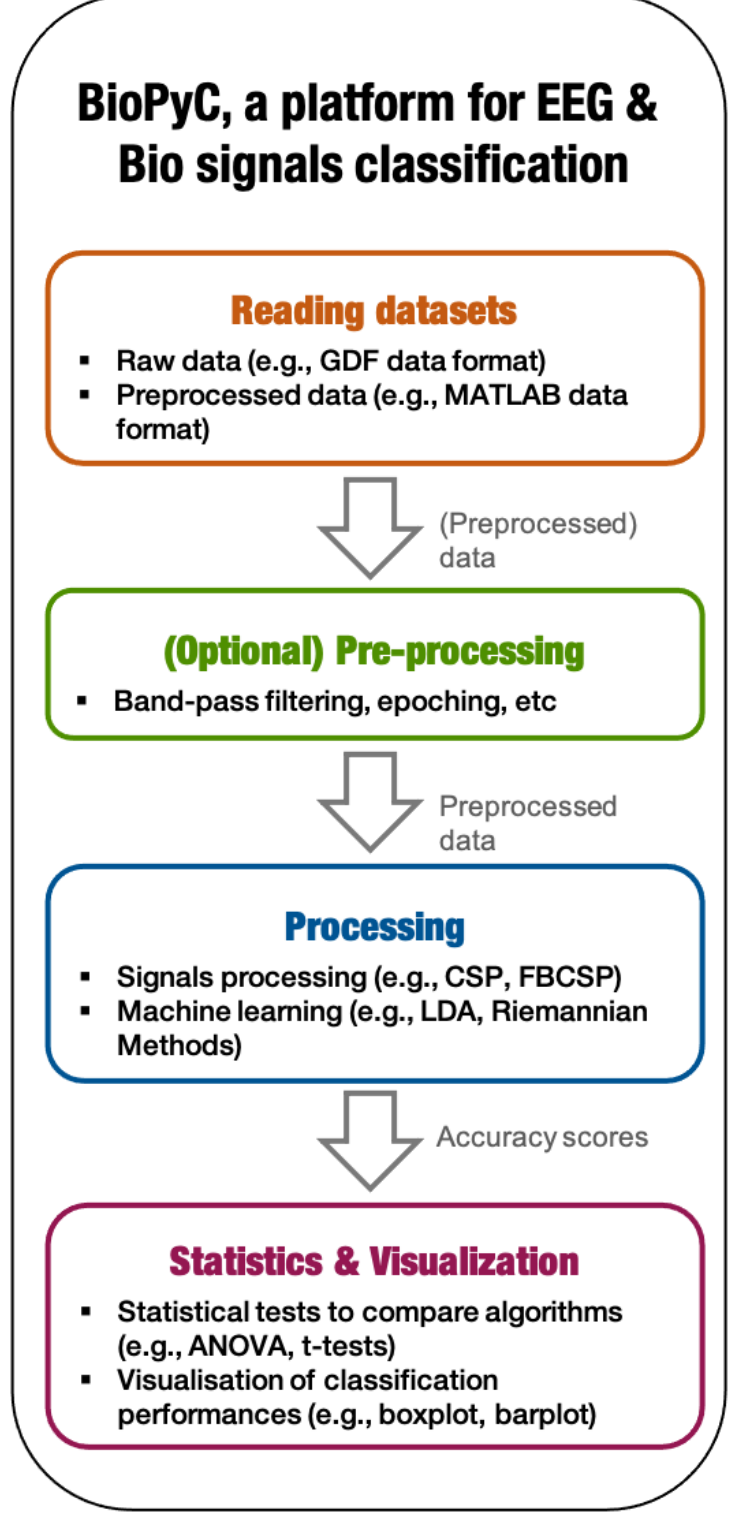
Figure 1. BioPyC data flow: the 4 main modules allow users to follow the standard BCI process for offline EEG and biosignal processing and